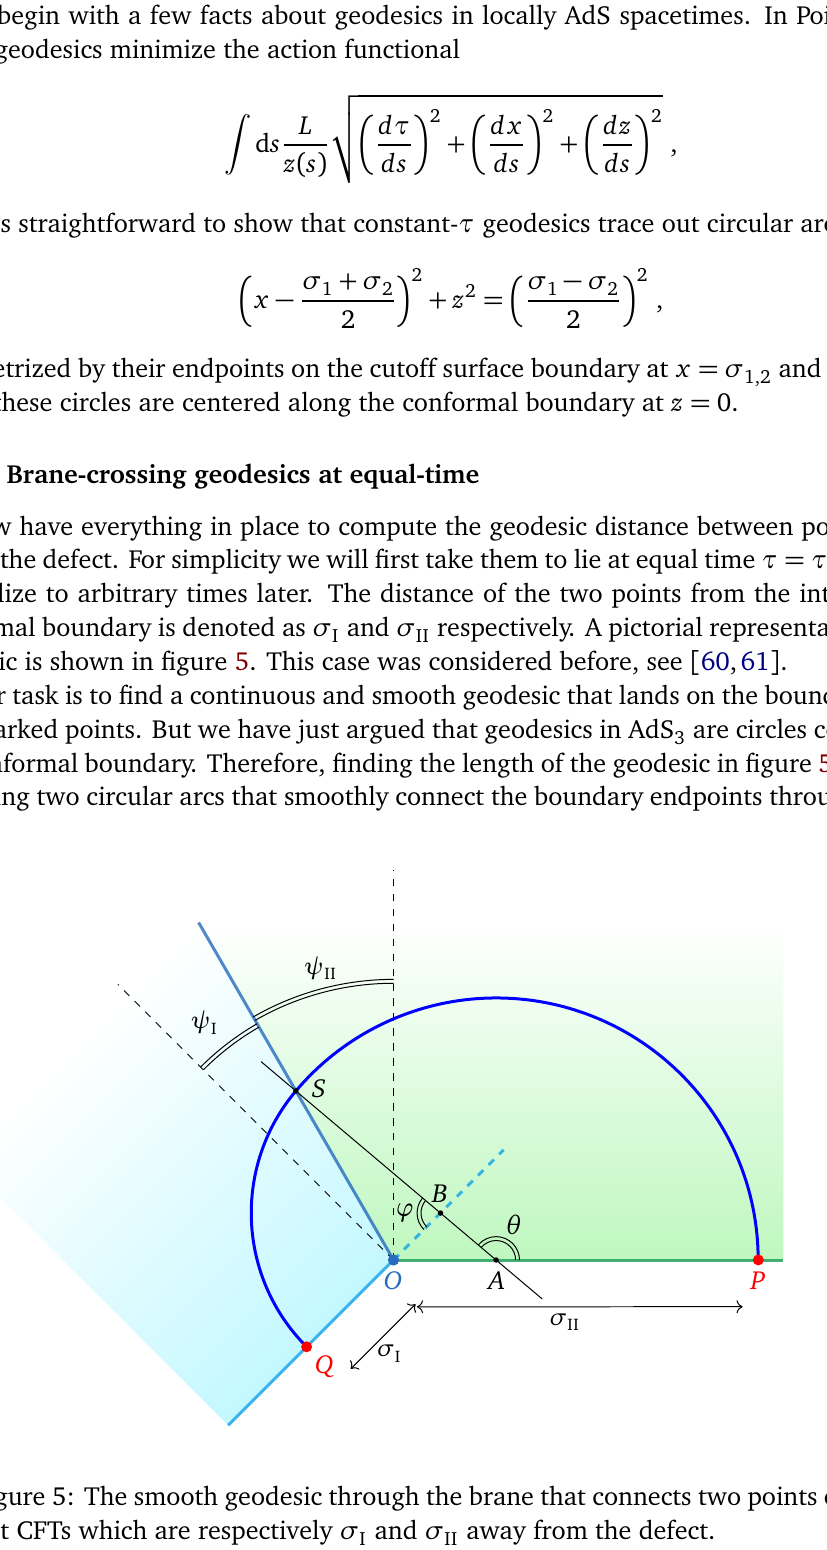
and σ away from the I II